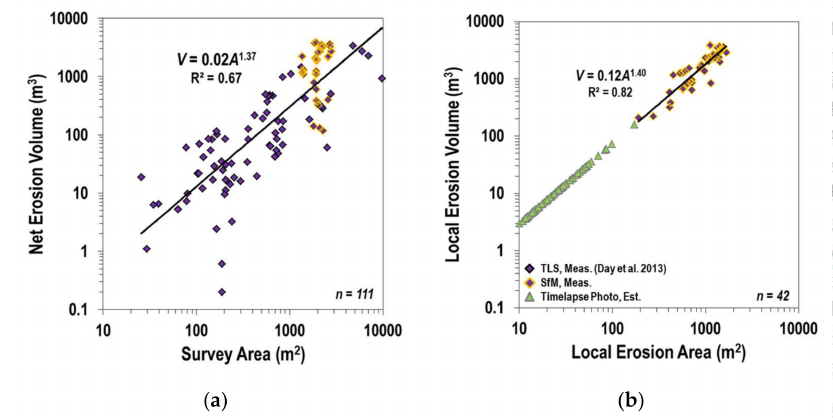
Figure 4. ( a ) Bluff retreat scaling relation (black line) between net bluff erosion volume ( V ) and bluff survey area ( A ) from repeat SfM surveys and Day et al. 2013a TLS surveys, 111 total observations. ( b ) Local scaling relation between measured total bluff erosion volume ( V ) and bluff erosion survey area ( A ) from repeat SfM surveys, 42 total observations. Data represented by green triangles were estimated using the locally measured erosion